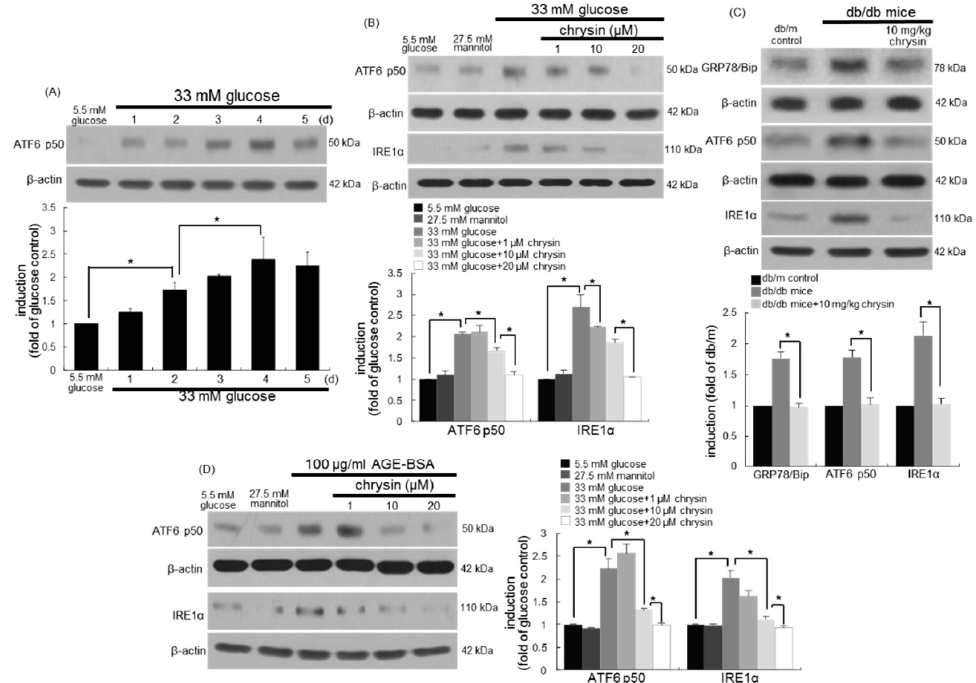
Figure 7. Induction of ER stress by glucose and AGE-BSA and its inhibition by chrysin. Human retinal pigment epithelial (RPE) cells were incubated with 33 mM of glucose ( A , B ) or 100 μ g/mL of AGE-BSA ( D ) in the absence and presence of between 1–20 μ M of chrysin for up to five days. Cells were also incubated with 5.5 mM of glucose and 27.5 mM of mannitol as osmotic controls. The db/db mice were orally supplemented with 10 mg/kg of chrysin daily for 10 weeks ( C ). The db/m mice were introduced as control animals. Cell lysates and tissue extracts were subject to Western blot analysis with a primary antibody against ATF6 p50, inositol-requiring enzyme 1 α (IRE1 α ), and 78 kDa glucose-regulated protein/binding immunoglobulin protein (GRP78/Bip). β -actin protein was used as an internal control. Bar graphs (mean ± SEM, n = nine independent experiments) in the bottom represent the densitometric results of upper blot or left bands ( A , B ). *, Values in bar graphs indicate a significant difference at p < 0.05.